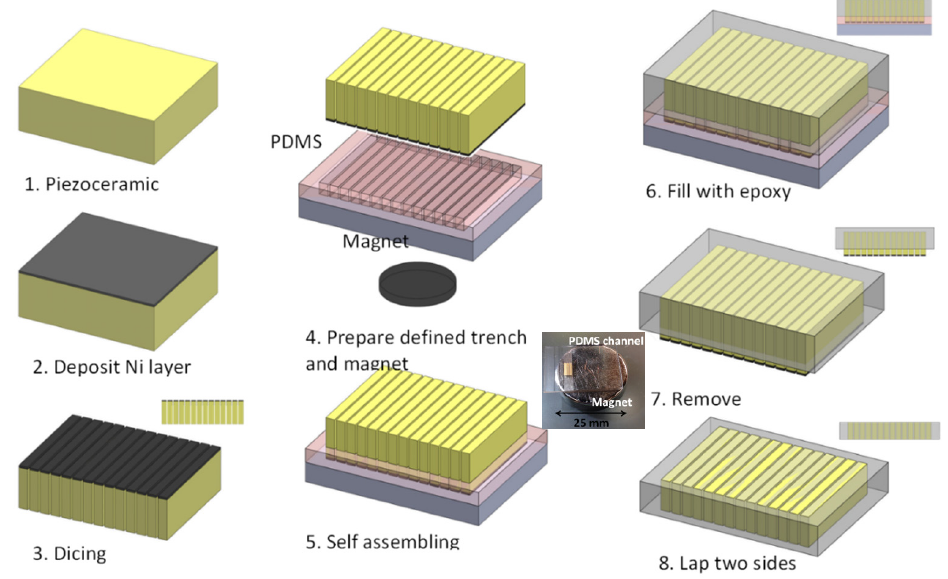
Figure 2. The fabrication process of a 2-2 composite by magnetic force-assisted self-assembly.